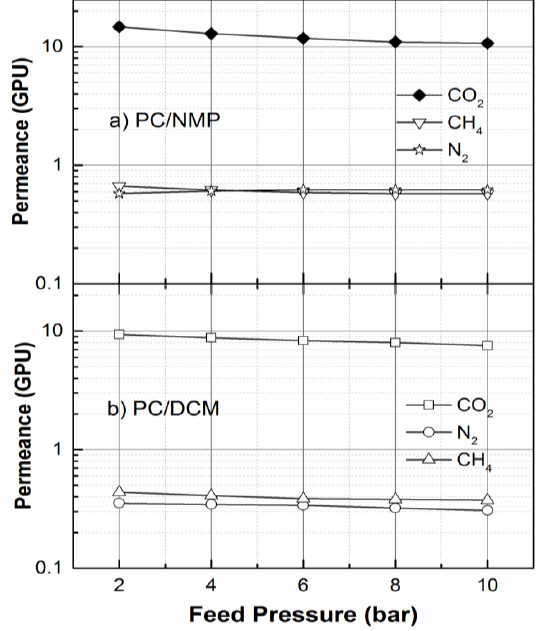
Figure 10. Gas permeances for ( a ) 18 wt % PC/NMP and ( b ) 18 wt % PC/DCM membranes at various feed pressures.